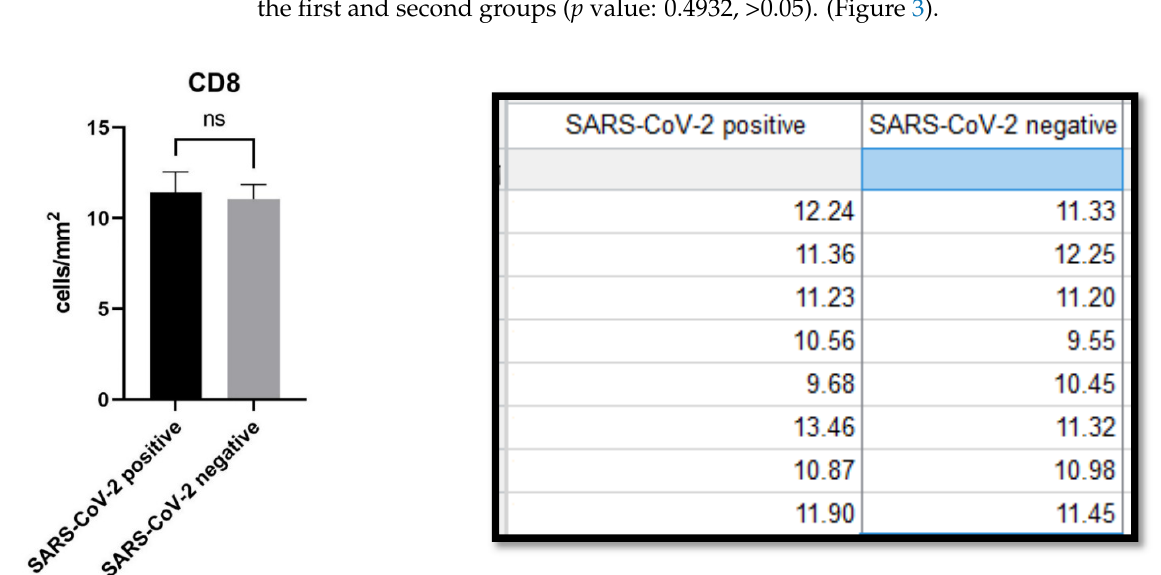
Figure 2. Table and graph relating to the density of CD4+ lymphocytes in the samples of the two groups. Note that there was no statistically significant difference ( p value 0.3380). ns notes not significant.